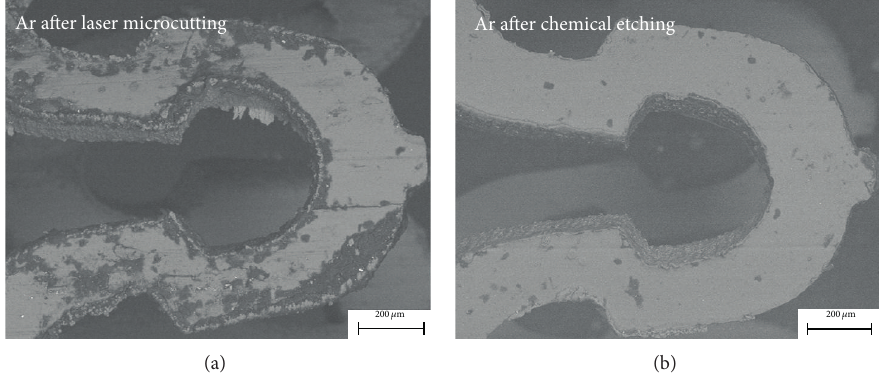
Figure 9: SEM images of stents cut with Ar, taken in back scattered electron mode .